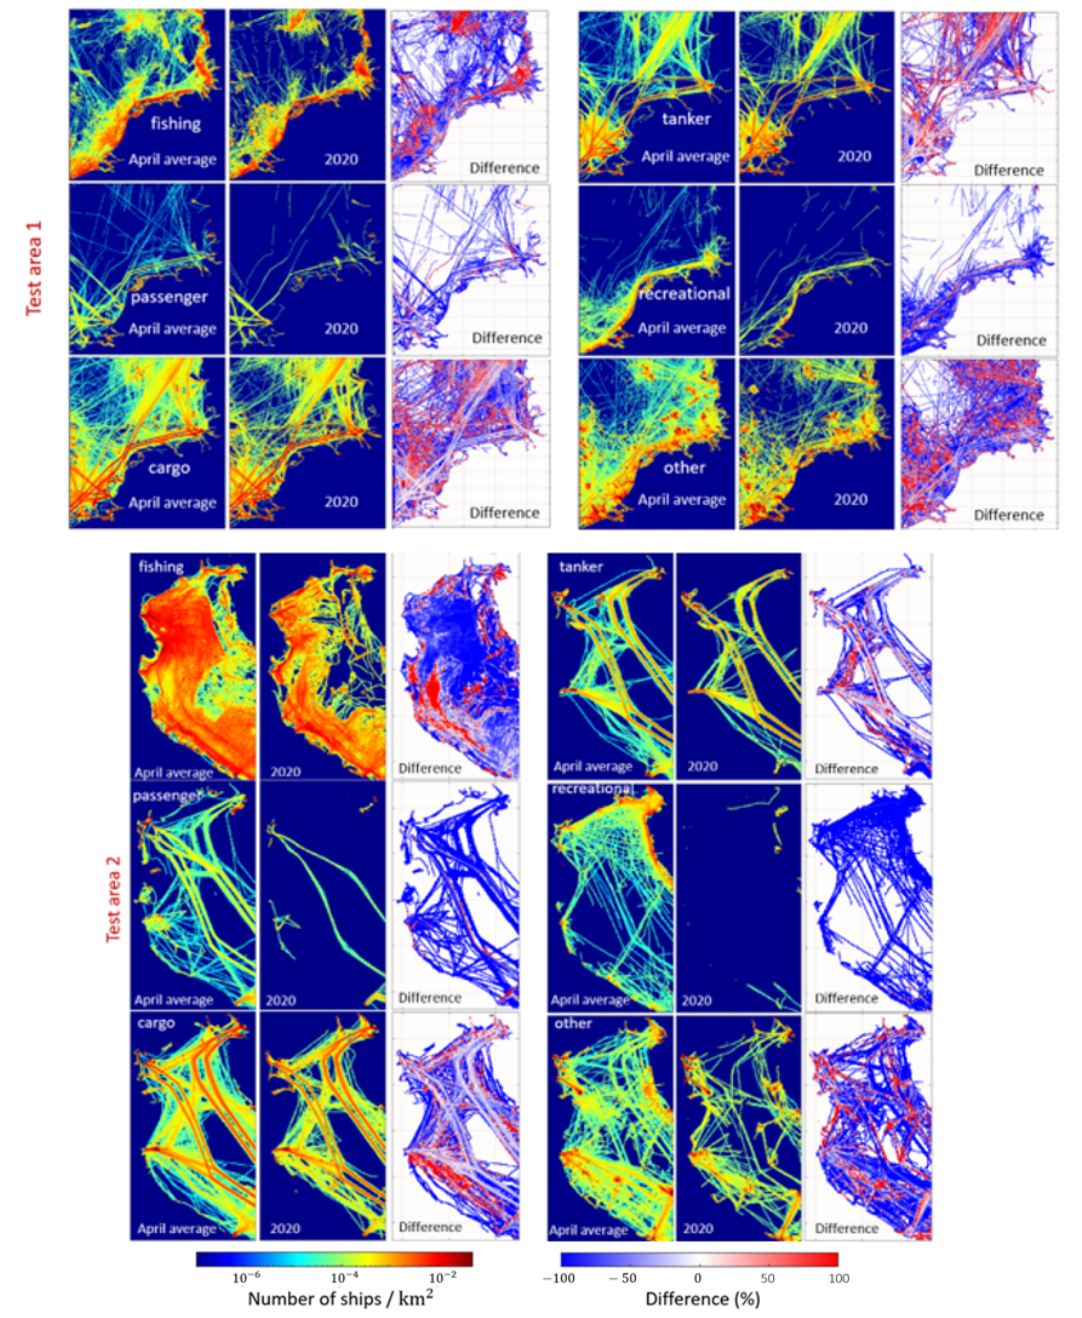
Figure 5. The shipping densities (number of ships per km 2 ) of the test area 1 ( upper ) and test area 2 ( below ) for April Average (over April 2017, 2018 and 2019) and April